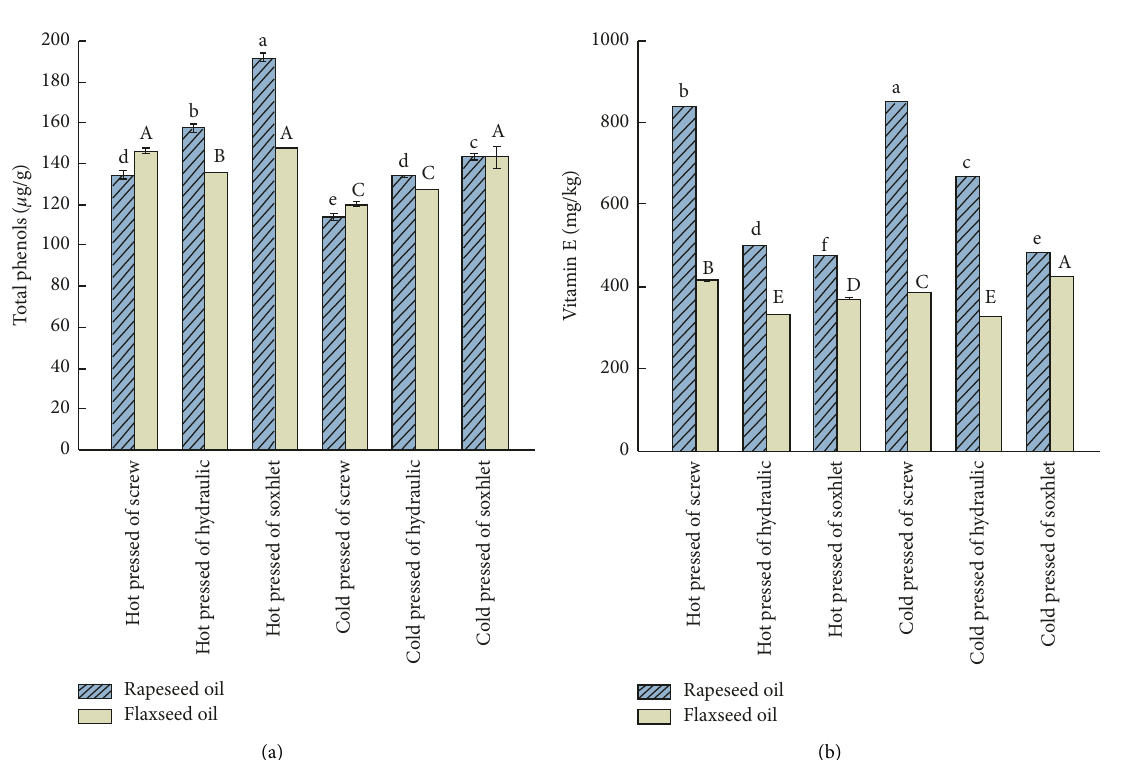
Figure 3: Total phenol and vitamin E contents in rapeseed and flaxseed oils. (a) Total phenol. (b) Vitamin E.